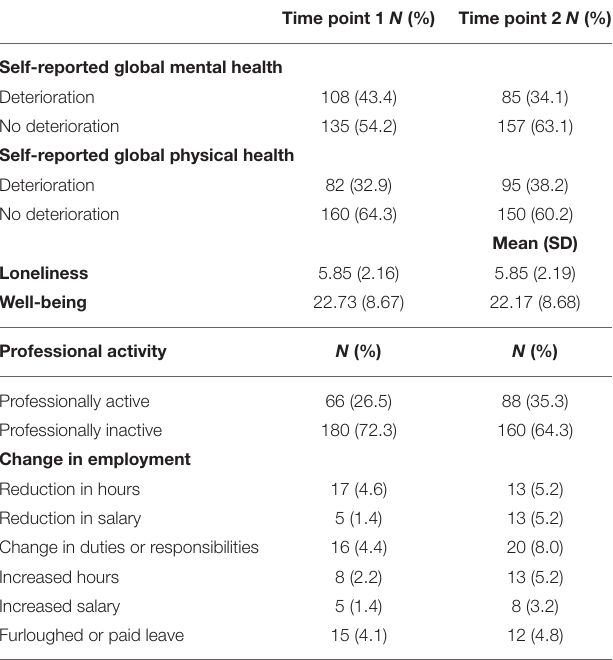
TABLE 2 | Self-reported health, professional activity, and changes in employment